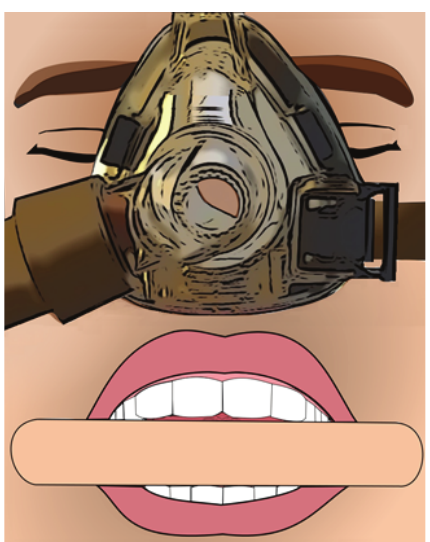
Figure 1: The Five-Minute CPAP Test setup. Front view of proper positioning of the soft-gel nasal triangle mask and tongue depressor (1.75 cm wide) which is placed between the teeth of the upper and lower jaw in order to standardize the distance the mouth is